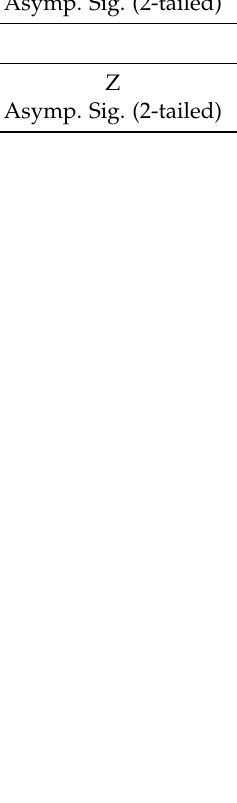
Table 5. Results of t -test about geographic